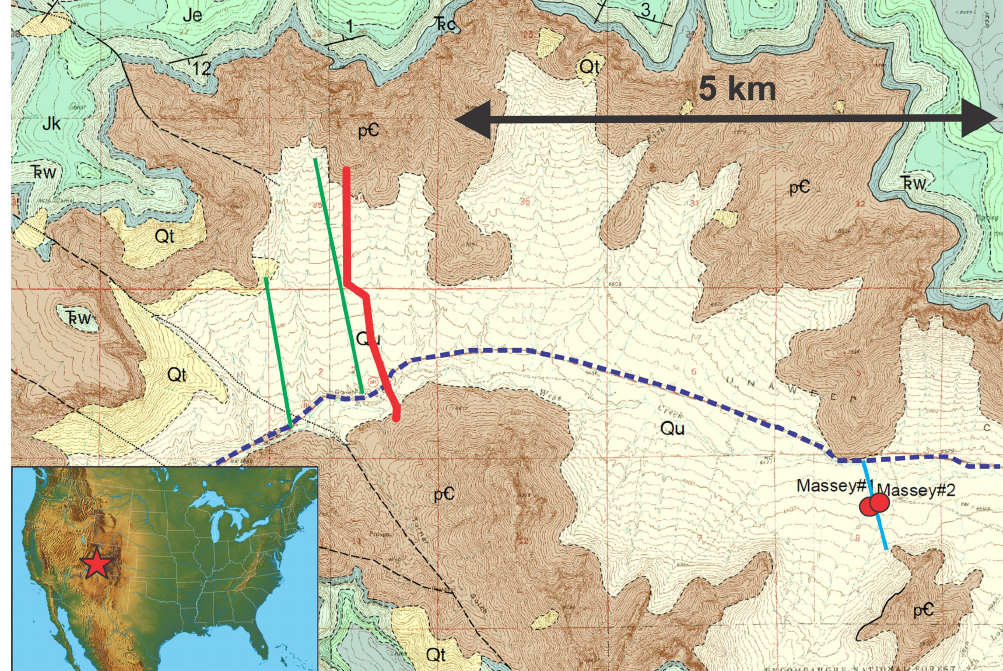
Figure 1. Surface geology of western Unaweep Canyon and the location of geophysical transects. pC: Precambrian granites (basement); Qu: unconsolidated Quaternary deposits; Qt: talus deposits; TRC, TRW, Je, Jk: Mesozoic sediments; red line: seismic acquisition 2017 (this study); blue line: seismic acquisition 2005; green lines: gravimetric acquisition 2006, 2014. Massey no. 1 and no. 2: wells (TVD 320m). Modified from Soreghan et al.